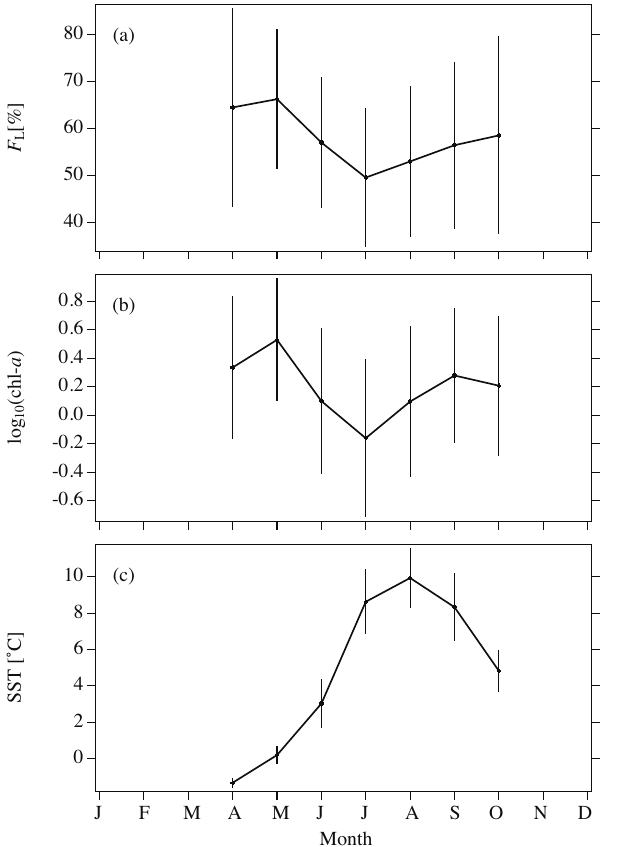
Fig. 7. Inter-annual variability of (a) F L , (b) chl- a , (c) a ph (488)/ a ph (555) and (d) γ in the box-averaged area (60–72 ◦ N, 166– 172 ◦ W) of August from 2003 to 2010. Error bars indicate the stan- dard deviation for each year. Red solid lines indicate regression line for the time series. F L and a ph (488)/ a ph (555) show significant de- crease ( r = − 0 . 78, p -value < 0.05) and increase ( r = 0 . 93, p -value < 0.001) along with the time series,